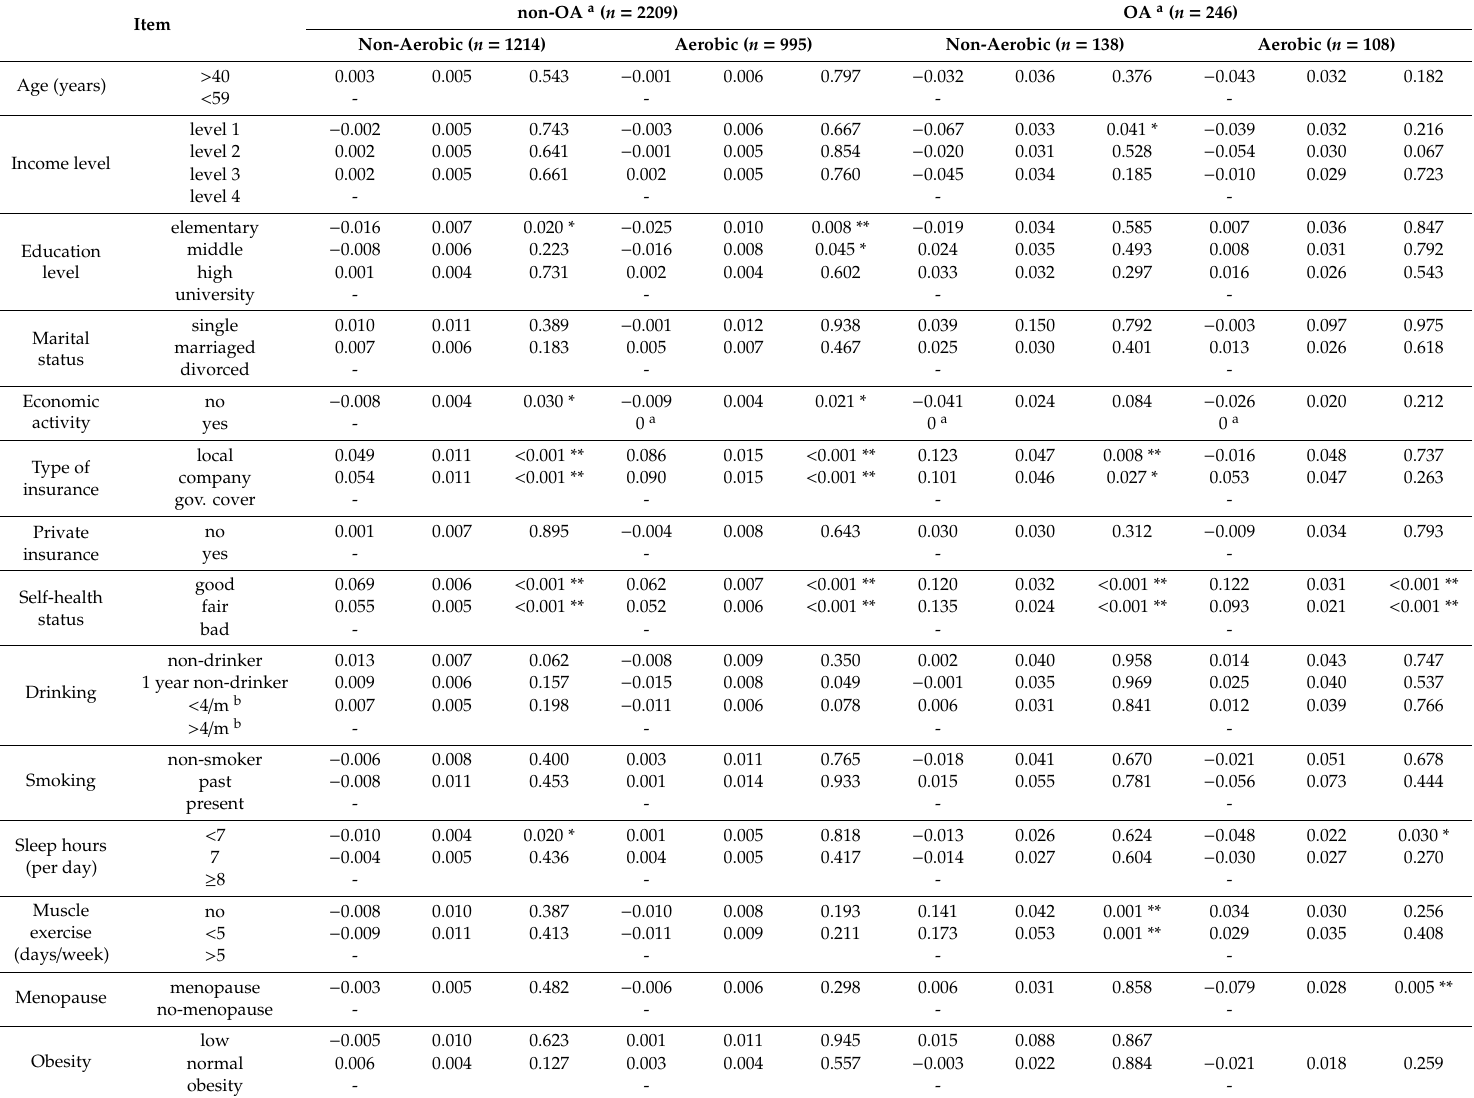
Table 3. Multiple linear regression analysis between osteoarthritis and aerobic